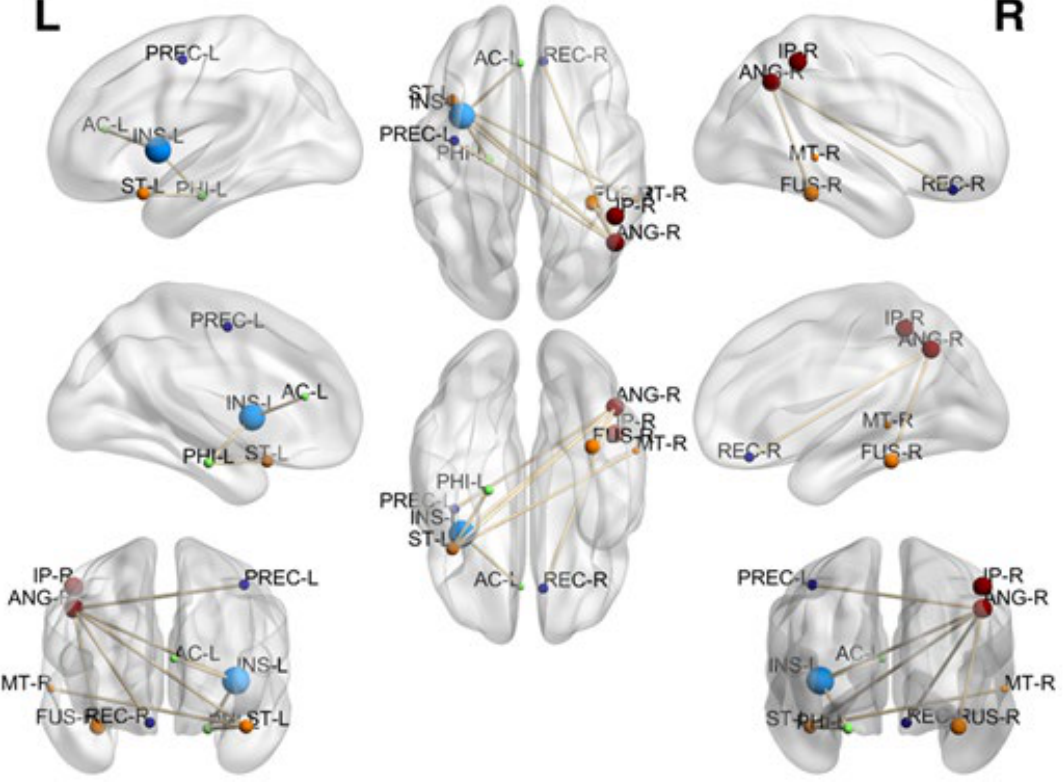
Figure 2. Connectivity pattern among most influential nodes at 3 Hz (T = 3.5, p < 0.001). L: left, R: right, AC-L: left anterior cingulate, MT-R: right middle temporal gyrus, PHI-L: left parahippocampal gyrus, PREC-L: left precentral gyrus, REC-R: right rectus, ST-L: left superior temporal gyrus, FUS-R: right fusiform, IP-R: right inferior parietal gyrus, ANG-R: right angular gyrus, INS-L: left insula.